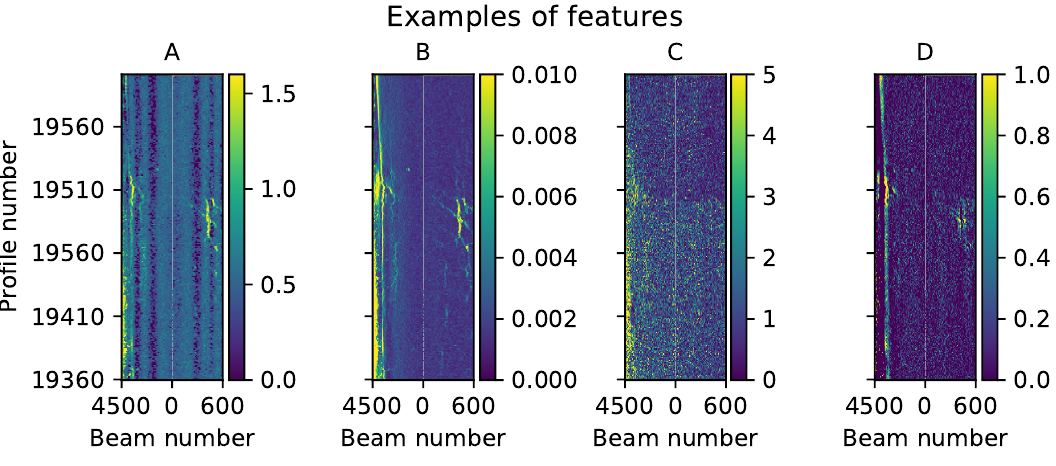
Figure 7. Input data, left the intensity, right the height in NAP [m]